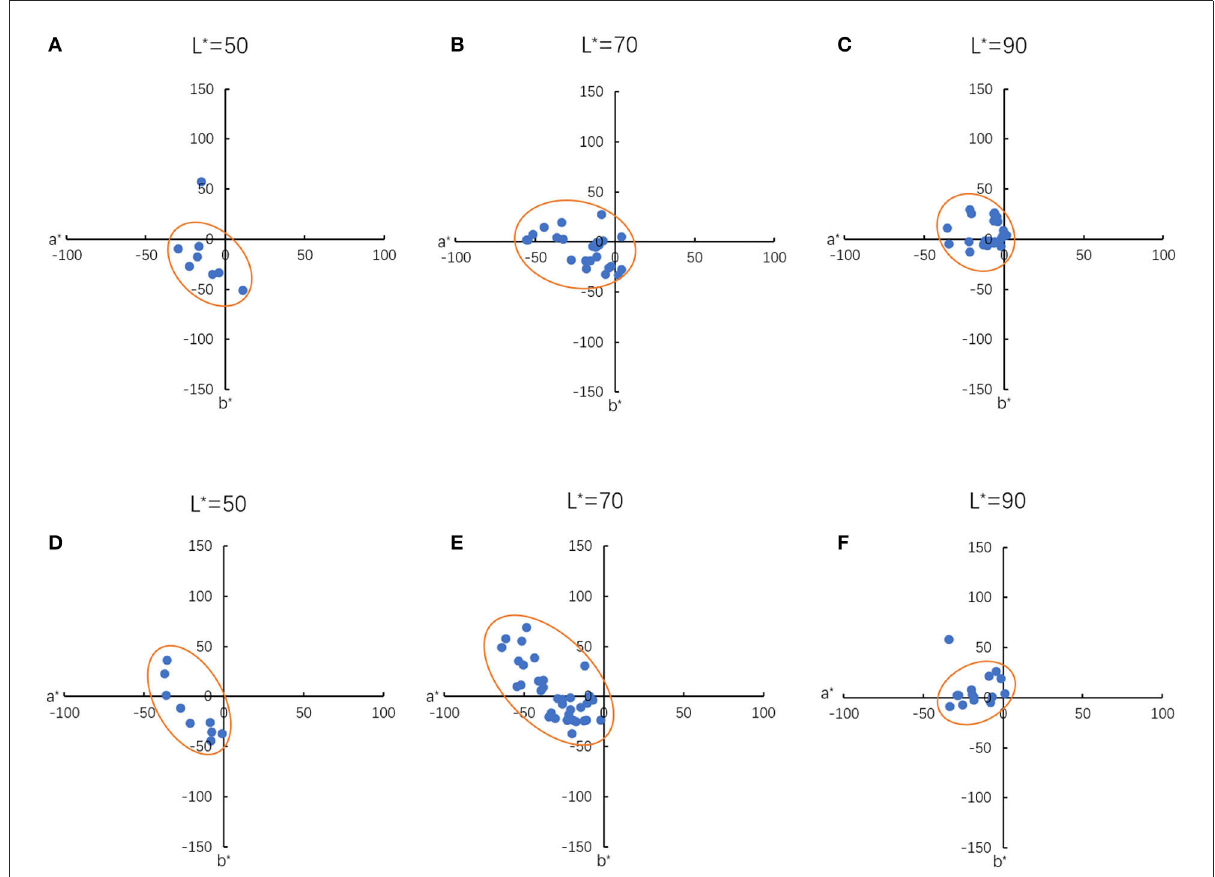
FIGURE3 Distribution of the experimental results in different lightness level. For dry at (A) L* = 50, (B) L* = 70, (C) L* = 90; for crisp (D) L* = 50, (E) L* = 70, (F) L* =